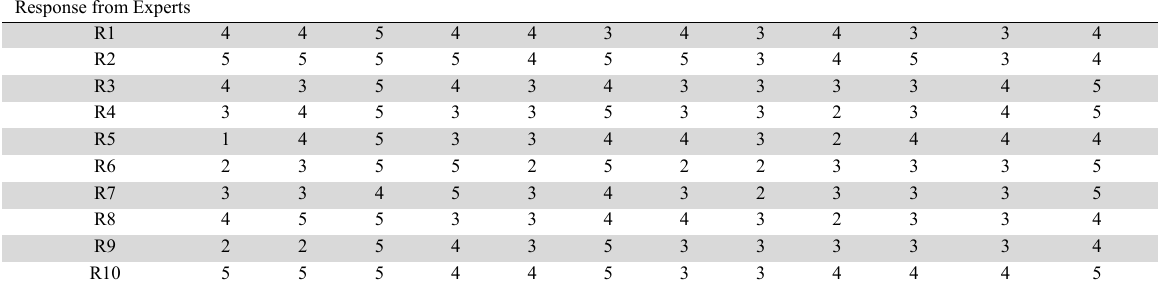
Survey values from 10 industry experts who are involved in supplier selection Response from